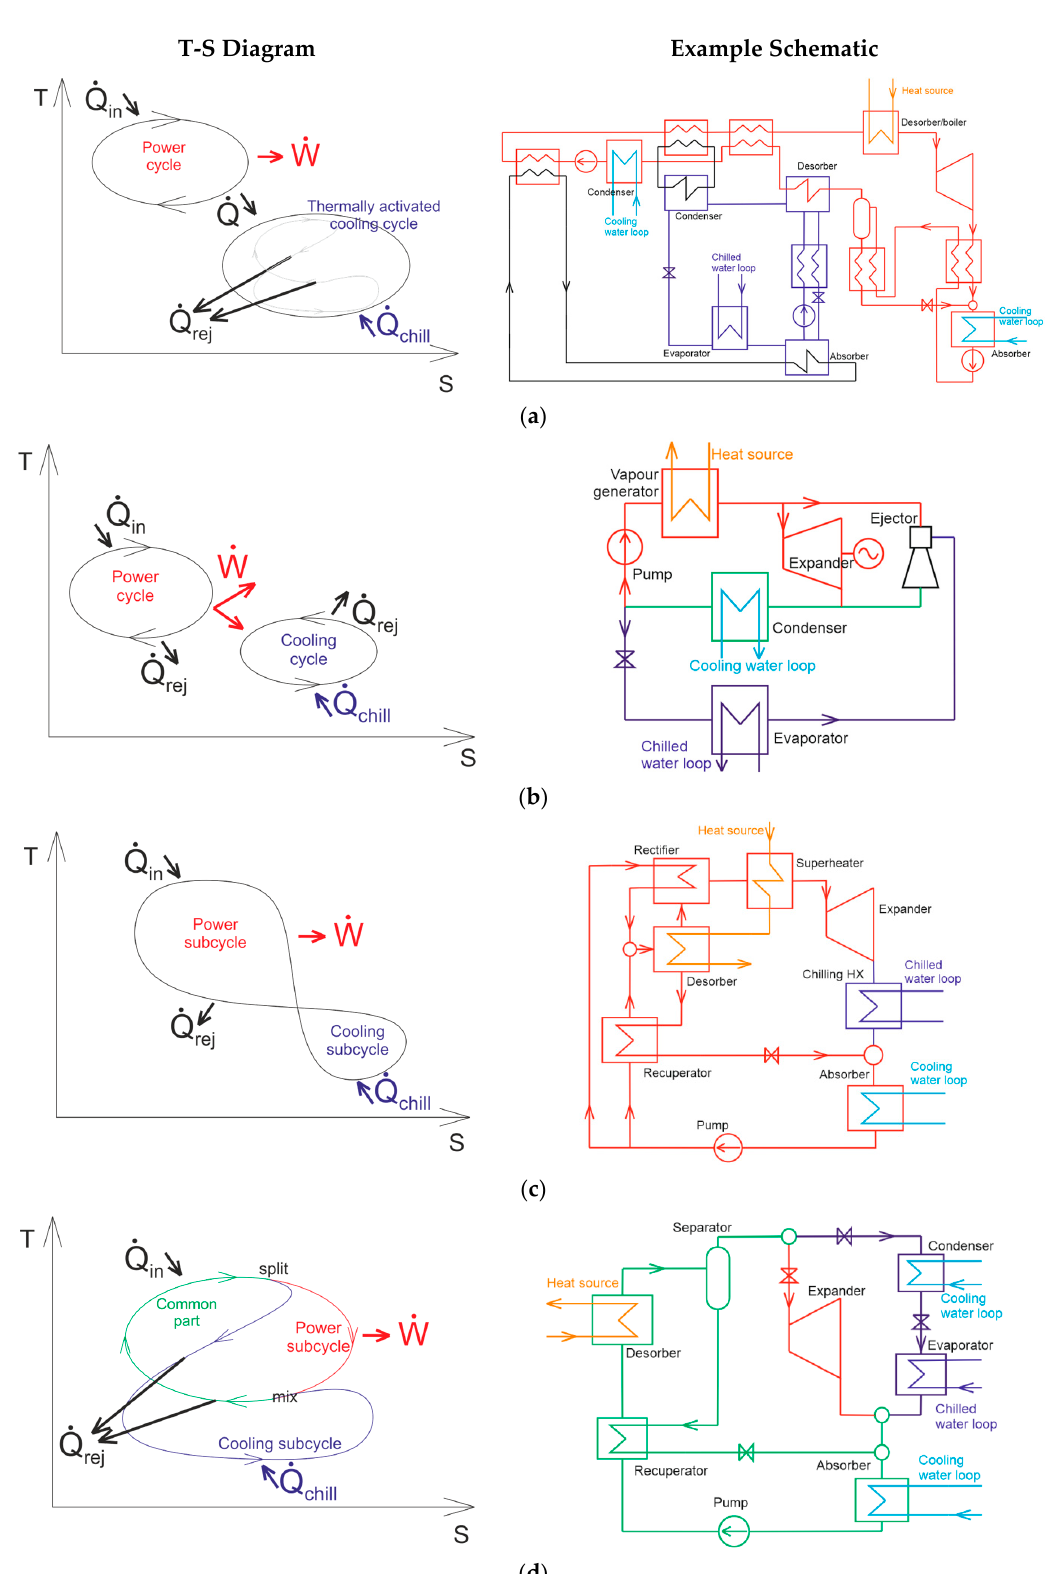
Figure 1. Schematic process diagrams of CCP systems with: ( a ) two separate cycles coupled by heat (example redrawn from [26]), ( b ) two separate cycles coupled by work (example redrawn from [31]), ( c ) single-branch thermodynamic cycle (example redrawn from [18]), and ( d ) two-branch thermodynamic cycle (example redrawn from